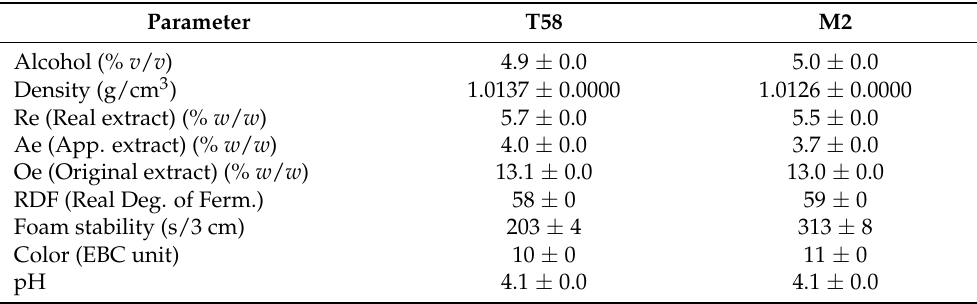
Table 2. Standard quality parameters of M2 and T58 beers. Values are averages of two measurements ± the standard deviation.